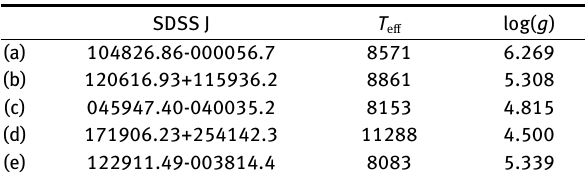
Table 2. Pure-hydrogen atmosphere spectral parameters for the objects shown in Table 1. As before, the uncertainties are of about 5–10 per cent in T eff and 0.25 dex in log g .